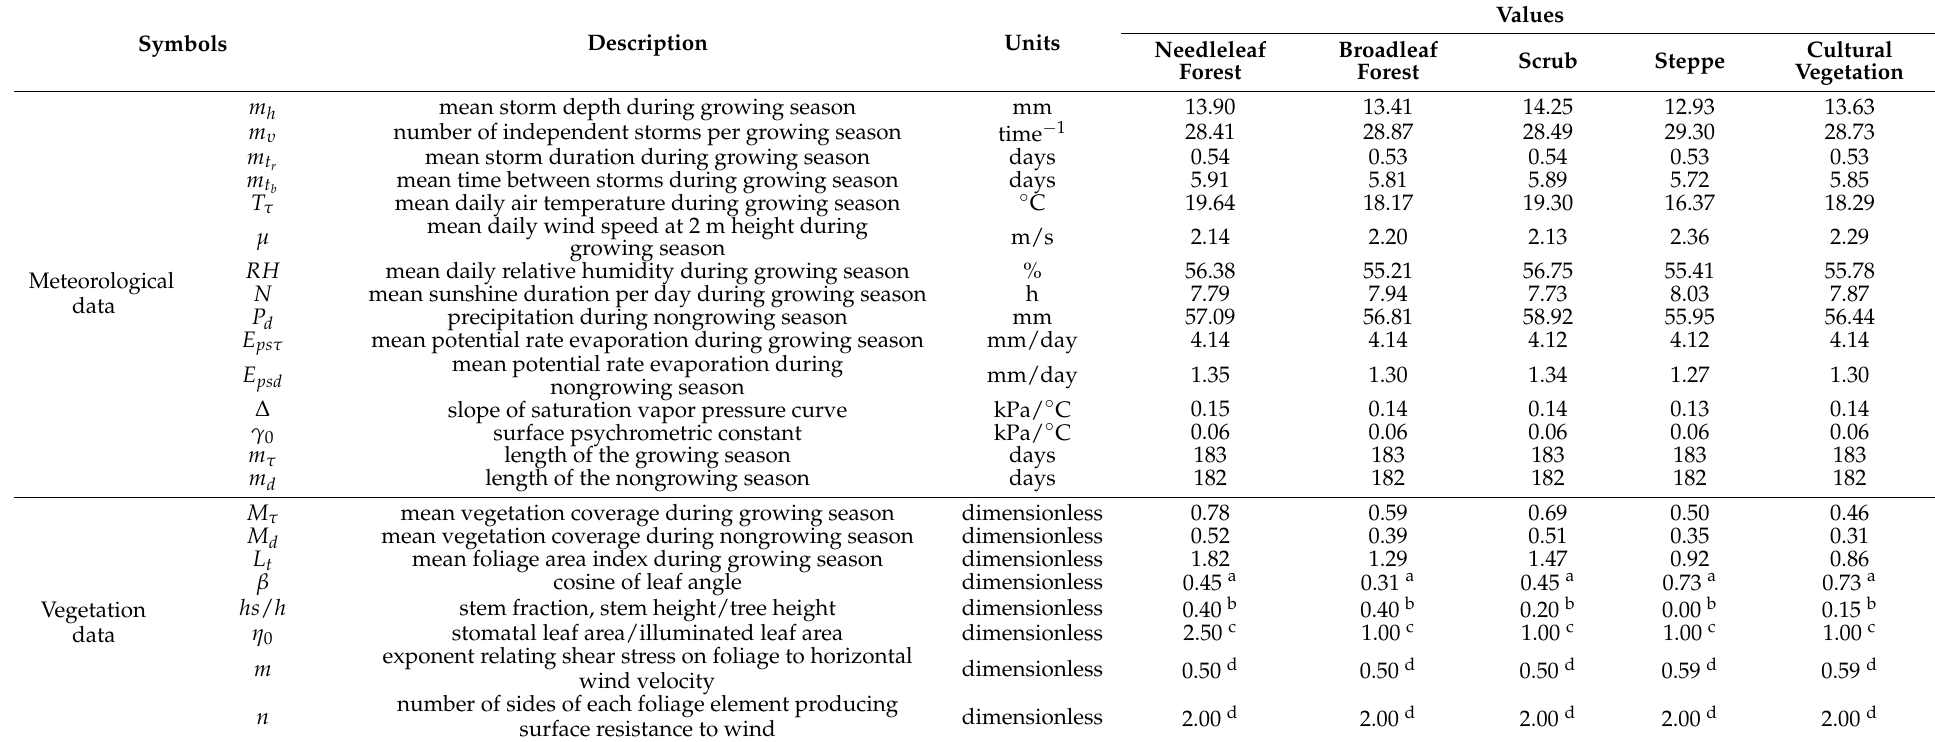
Table 1. The symbols, description, and values of meteorological data and vegetation data of five vegetation